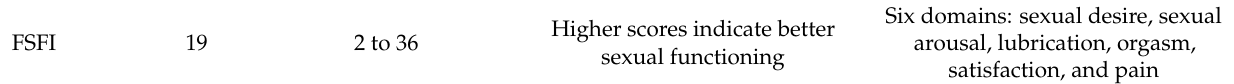
Legend to Table 1: International Consultation on Incontinence-Questionnaire for Urinary Incontinence Short Form (ICI-Q UI SF), OverActivity of the Bladder Questionnaire (OAB-q), Actionable Bladder Symptom Screening